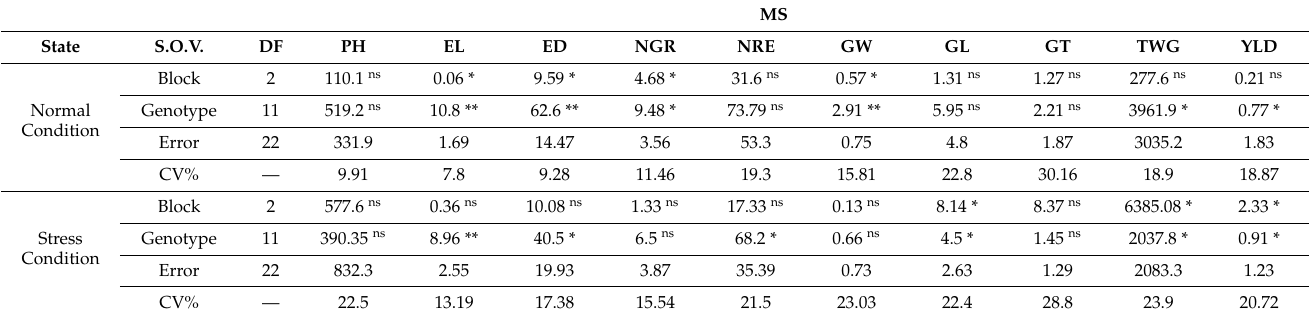
Table 1. Analysis of variance of studied hybrids in terms of traits under normal conditions and humidity stress.